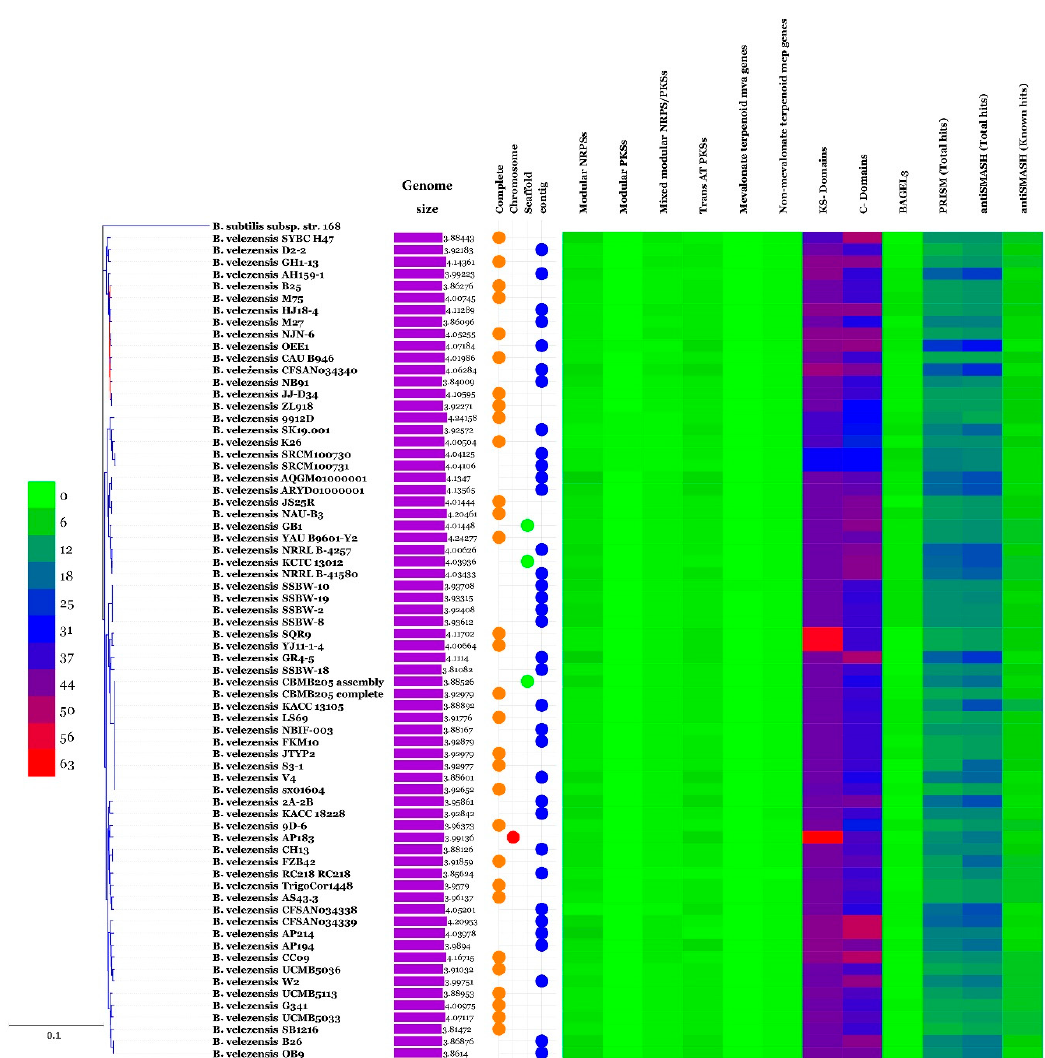
Figure 5. Genome size (MB), level of whole genome sequencing and a heat map resulting from the genome mining of genes contributing to secondary metabolite clusters. Gene copy number varies between 0 and 63, according to the indicated colour code. 475